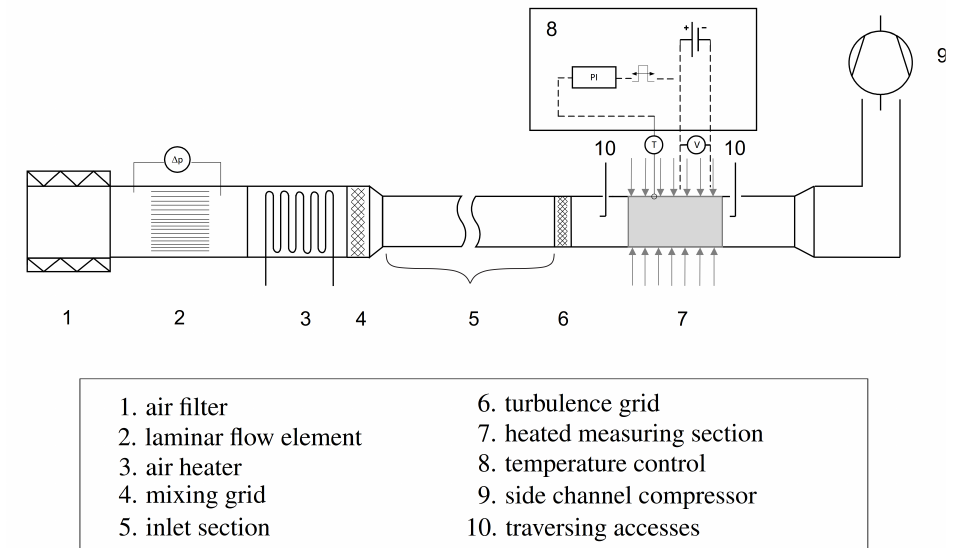
Figure 1. Overview of thecooling channel test